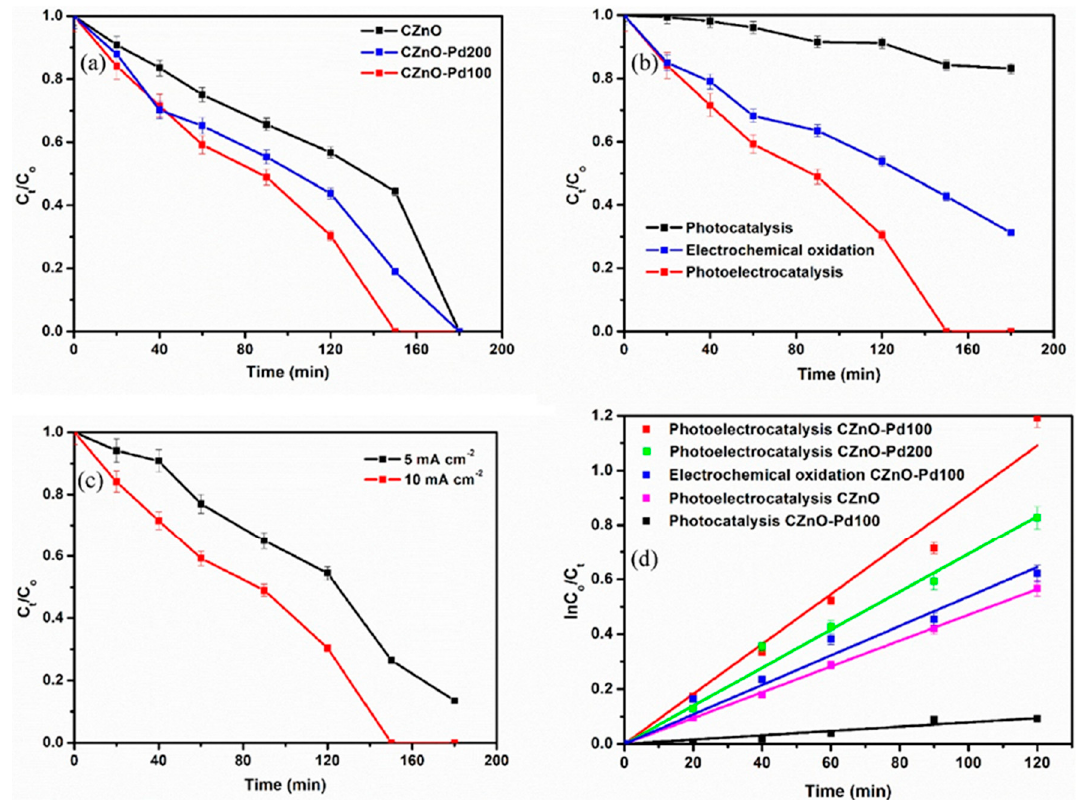
Figure 7. Normalized concentration decay versus time plot for PEC degradation of paracetamol using ( a ) CZnO, CZnO–Pd100 and CZnO–Pd200; ( b ) photocatalysis, electrochemical oxidation and photoelectrocatalysis using CZnO–Pd100; ( c ) photoelectrocatalysis at different current densities using CZnO–Pd100; ( d ) corresponding kinetics plot for the processes at 10 mA cm − 2 (0.1 mM paracetamol; pH 7; 50 mM Na 2 SO 4 ). Reproduced with permission [63].